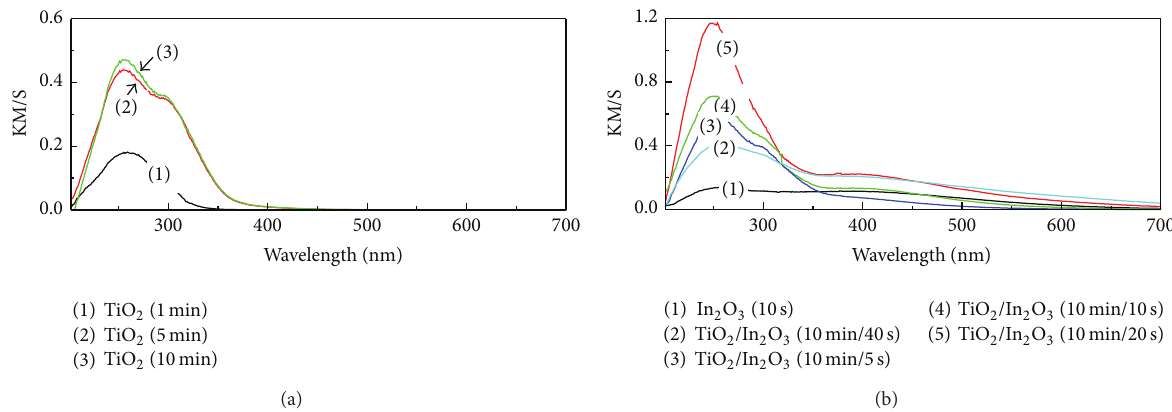
Figure 10: Diffuse reflectance spectra (DRS) of TiO 2 and TiO 2 /In 2 O 3 samples in Kubelka-Munk units: (a) TiO 2 1min, TiO 2 5 min, and TiO 2 10min. (b) TiO 2 10min/In 2 O 3 5s, TiO 2 10 min/In 2 O 3 10s, TiO 2 10min/In 2 O 3 20s, and TiO 2 10 min/In 2 O 3 40 s, In 2 O 3 10